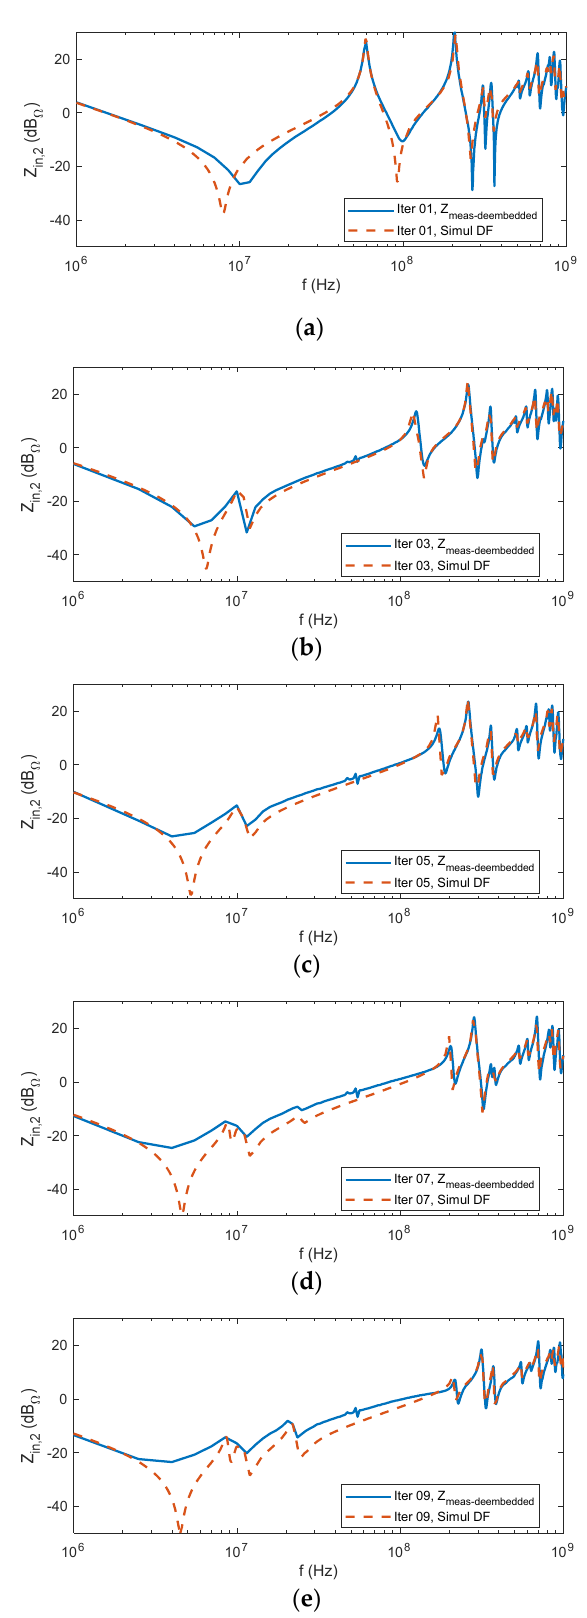
Figure 13. Comparisons between measured and simulated impedances at port P 2 for di ff erent numbers